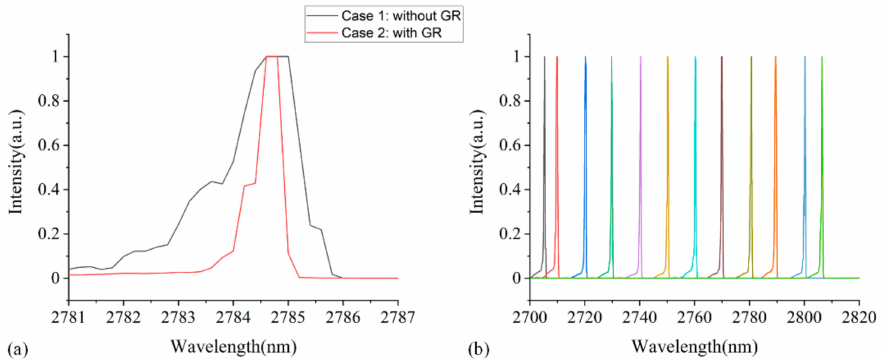
Figure 5. ( a ) The output spectra around 2784.5 nm in Case 1 and Case 2. ( b ) Tuning the central lasing wavelength in Case 2 by rotating the angle of the grating.